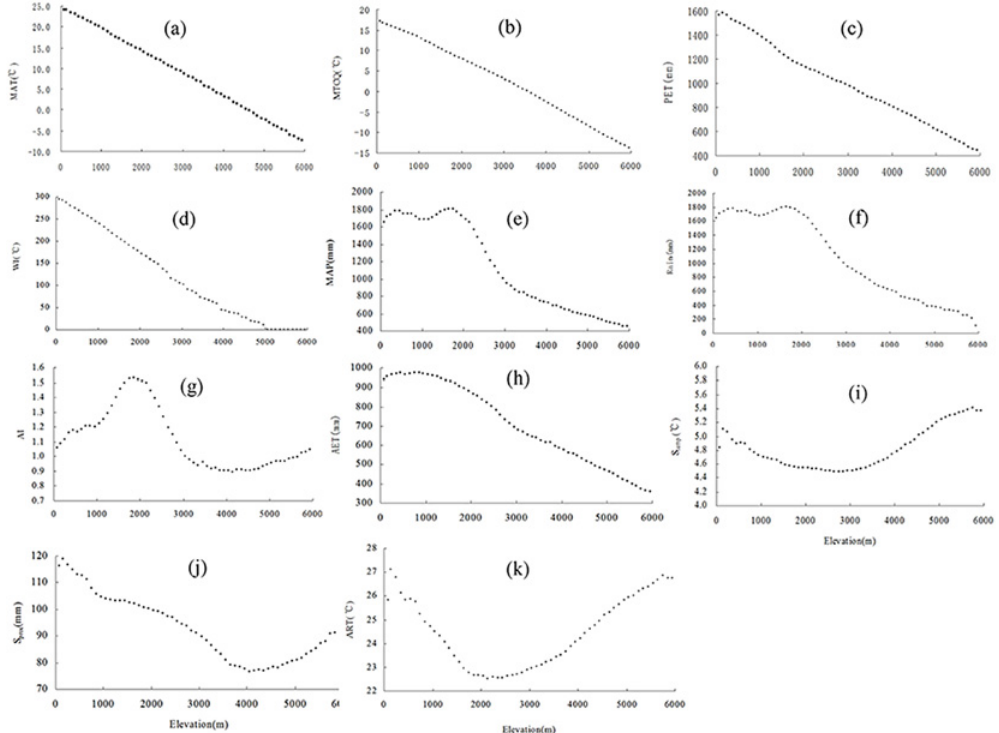
Fig 1. Climatic factors on elevation. Subgraphs: (a) = mean annual temperature (MAT), (b) = mean temperature of the coldest quarter (MTCQ), (c) = annual potential evapotranspiration (PET), (d) = warmth index (WI), (e) = mean annual precipitation (MAP), (f) = Rain, (g) = aridity index (AI), (h) = annual actual evapotranspiration (AET), (i) = temperature seasonality (S Temp ), (j) = precipitation seasonality (S Prec ), and (k) = annual range in temperature (ART).